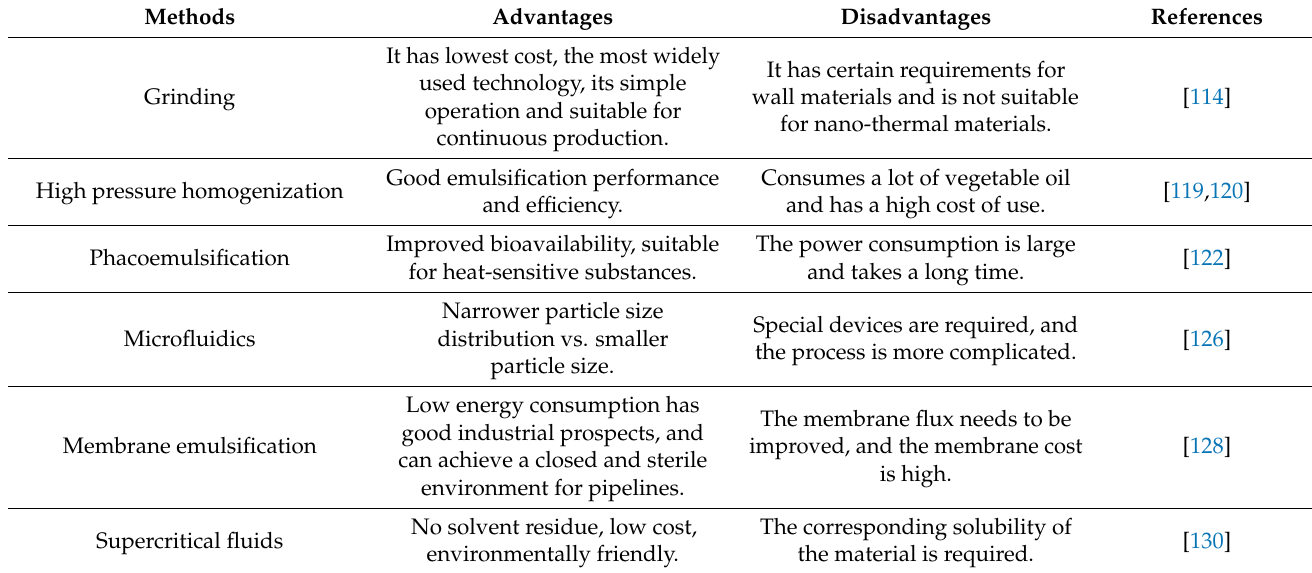
Table 5. Advantages and disadvantages of common food processing